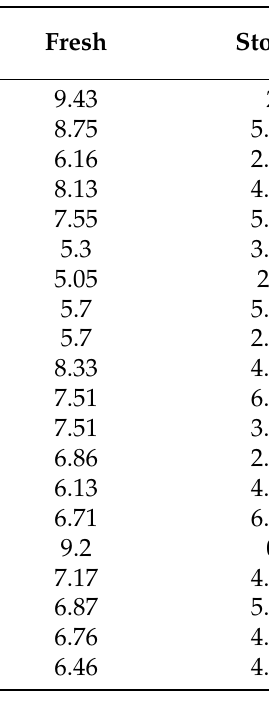
Table 2. Effects of storage time and temperature on albumen